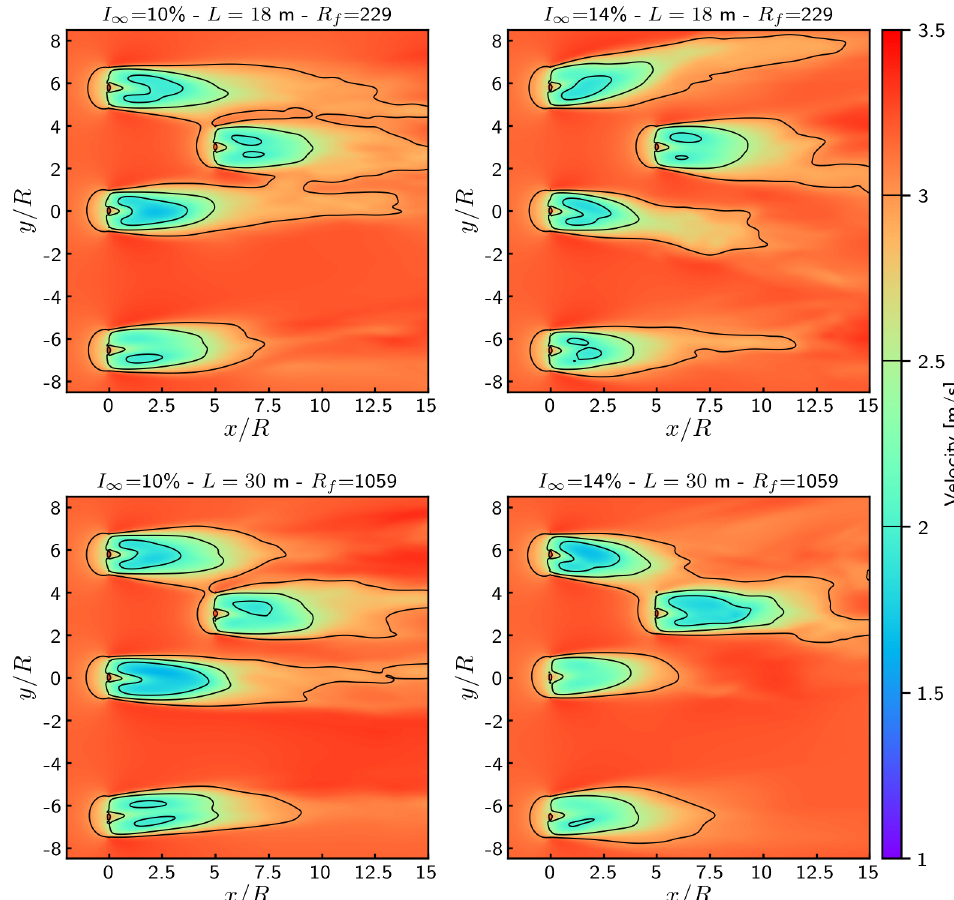
Figure 12. Time-averaged wakes obtained for two turbulence intensities and two integral length scales (TSR = 4.1, σ ( λ ) =